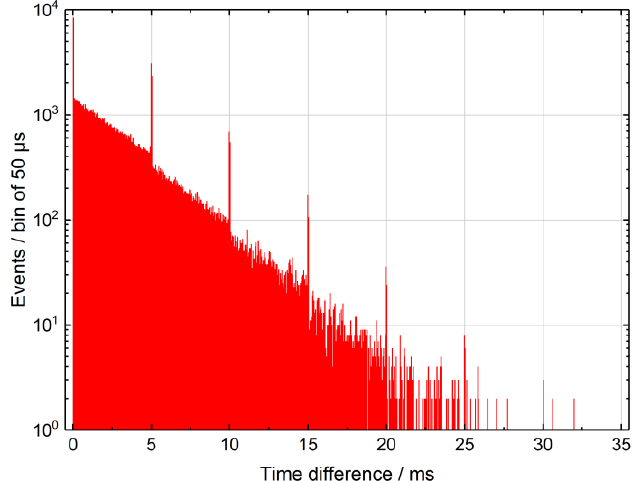
Fig. 5. Time difference histogram for the case of the accelerator switched on and with the 22 Na source. The accelerator current was of 25